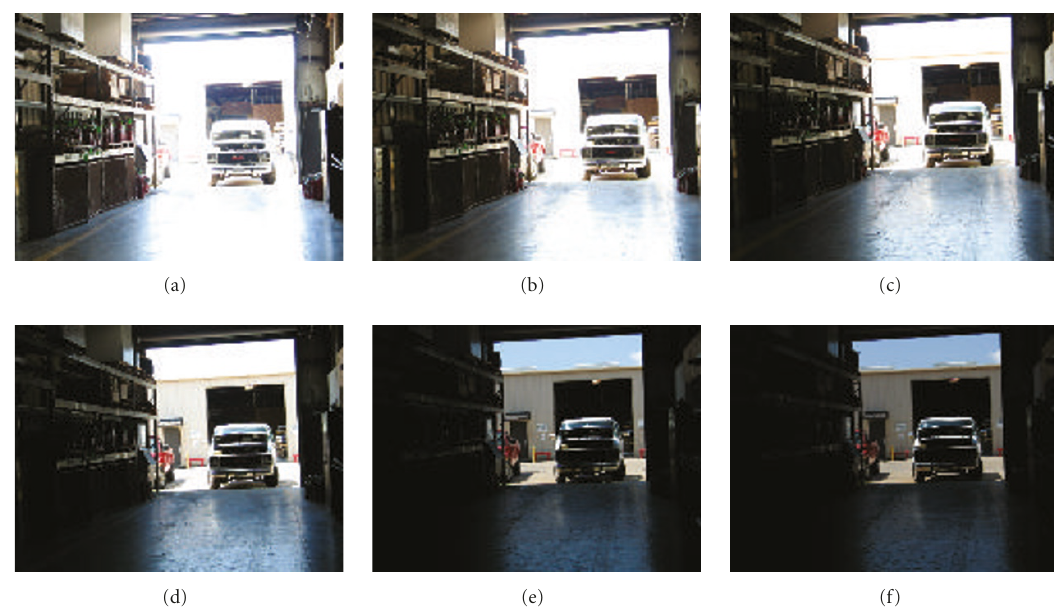
Figure 8: Six images of “Facility II” data set that includes 31 images are displayed here. Exposure durations of (a)–(f) are 1 / 25, 1 / 50, 1 / 100, 1 / 200, 1 / 400, and 1 / 800 seconds, respectively.